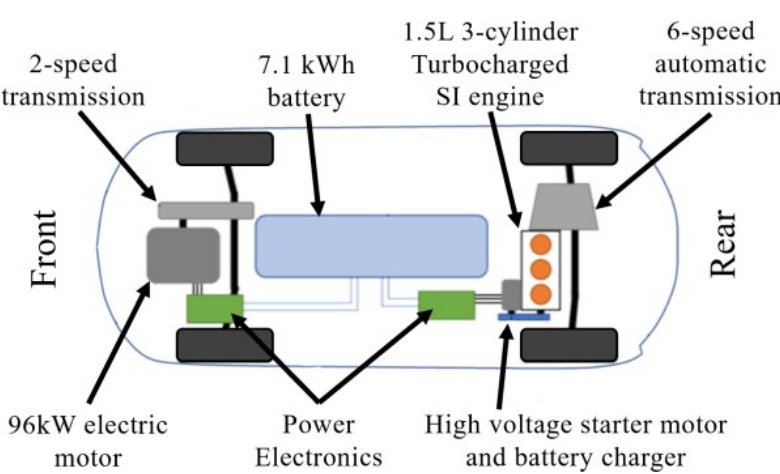
Figure 3. The BMW i8 test vehicle installed on the chassis dynamometer facility at IAAPS, Univer- sity of Bath [26].